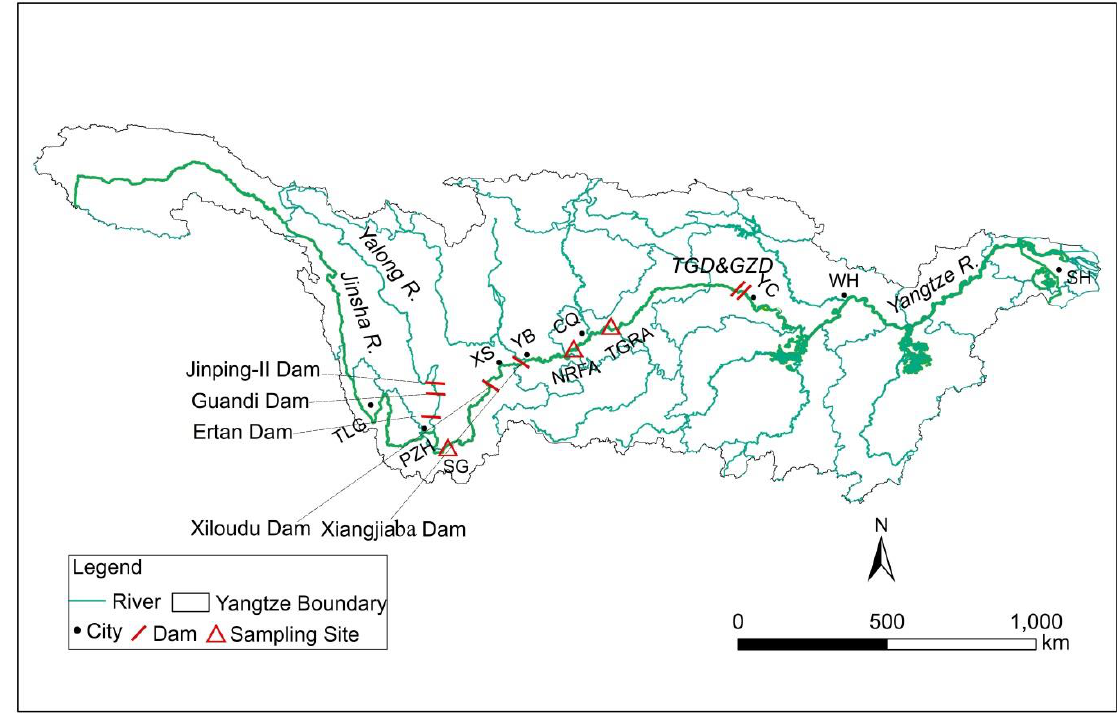
Figure 1. The study area and fish sampling sites in the Yangtze River Basin (SG: spawning ground; NRFA: natural riverine feeding and nursery area; TGRA: Three Gorges Reservoir area; SH: Shanghai; WH: Wuhan; YC: Yichang; CQ: Chongqing; YB: Yibin; XS: Xinshi; PZH: Panzhihua; TLG: Tiger leaping Gorge; TGD: Three Gorges Dam; GZD: Gezhou Dam).